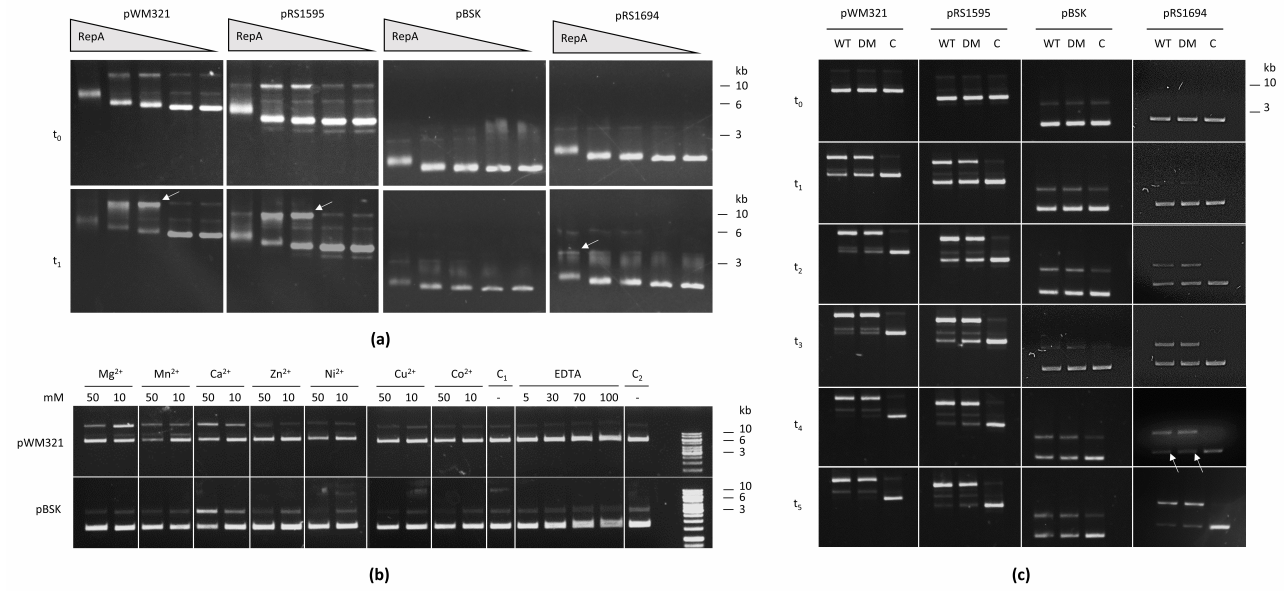
Figure 5. Binding and nicking activity of RepA of archaeal shuttle vectors and bacterial plasmids. ( a ) An electrophoretic mobility shift assay was performed on 1% agarose. In each case, 100 ng plasmid and 250, 100, 50, 10 and 0 ng purified RepA (from left to right) was used in 10 mM Tris (pH 6.9, 500 µ M MgCl 2 ). The archaeal shuttle vectors pWM321 and pRS1595 were compared with the bacterial plasmid pBSK and pRS1694, pBSK containing a 345 bp fragment of the archaeal replicon. The mixtures were incubated at room temperature for 10 min and subsequently loaded on a gel (t0) in native buffer (25% glycerol, 0.05% bromophenol blue). The remaining assays were further incubated for 10 min at 37 ◦ C before samples were taken (t1). The gel was run for 2 h at 30 V. ( b ) The effect of different metal ions on the activity of RepA was investigated. In each case, 100 ng of plasmid and 20 ng of protein were used in 10 mM Tris (pH 6.9). The mixtures were supplemented with 10 or 50 mM of different divalent metal ions or 5–100 mM EDTA. Control 1 was a mixture of plasmid and RepA without supplementation, while control 2 was only plasmid without RepA. After incubation at 37 ◦ C for 30 min, stop buffer (30 mM Tris, 300 mM EDTA, 0.1% SDS, 25% glycerol, 0.05% bromophenol blue) was added and samples were loaded on a 1% agarose gel. ( c ) The nicking activity of RepA (WT) and RepA_Y301F_Y303F (DM) was compared for pWM321, pRS1595, pBSK and pRS1694. In each case, 100 ng of plasmid and 20 ng of protein was used in 10 mM Tris (pH 6.9, 10 mM MgCl 2 ). The mixtures were incubated at 37 ◦ C and samples were taken after 0, 15, 30, 45, 60 and 90 min. For each condition, a control C without RepA was